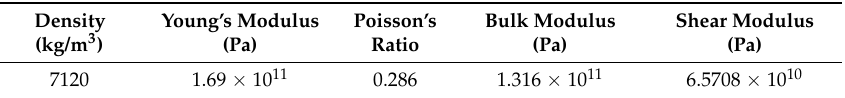
Figure 2. Boundary constraints of cylinder liner: ( a ) Boundary conditions of the cylinder liner; ( b ) Finite element model of the studied cylinder liner. Table 1. Material properties of QT600-3.